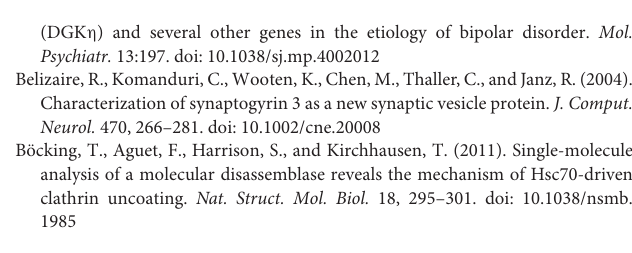
Supplementary Figure 2 | Dynamin-1, synaptogyrin-1, Syt1, CaMKII α , Munc18-1, Hsc70, and syntaxin-7, all biochemically-confirmed DGK θ -interacting proteins, did not pull down with DGK θ when isolated with a non-specific mouse IgG. Supplementary Table 1 | Detailed data from mass spectrometry experiment 1. Supplementary Table 2 | Detailed data from mass spectrometry experiment 2. Supplementary Table 3 | Detailed data from mass spectrometry experiment